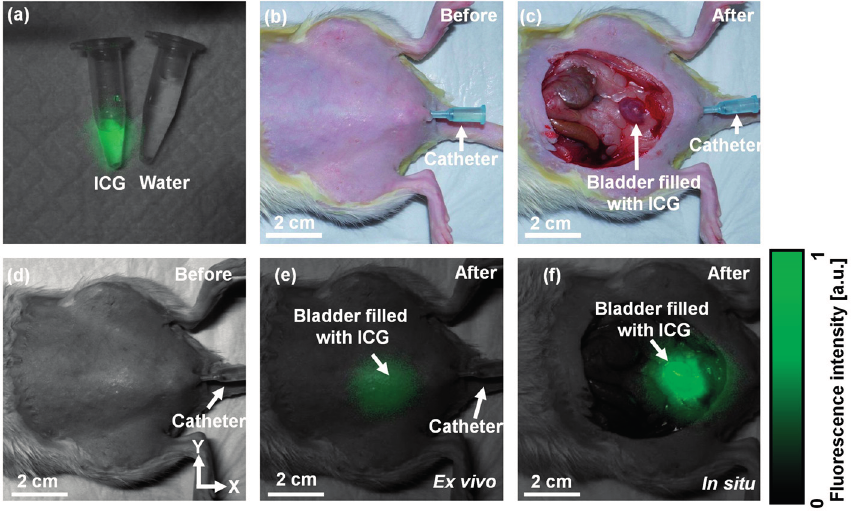
Figure 4. In vivo nonionizing and noninvasive fluorescence (FL) cystography using indocyanine green (ICG). ( a ) Combined FL and white-light image of ICG (15 µM) and water in plastic tubes; ( b ) Photograph taken before FL imaging and ICG injection; ( c ) Photograph taken after FL imaging and skin removal; ( d ) Control overlaid FL and white-light image of the rat’s abdomen before ICG injection; ( e ) In vivo overlaid FL and white-light image after ICG injection; ( f ) In situ overlaid FL and white-light image after ICG injection and skin removal. BD,